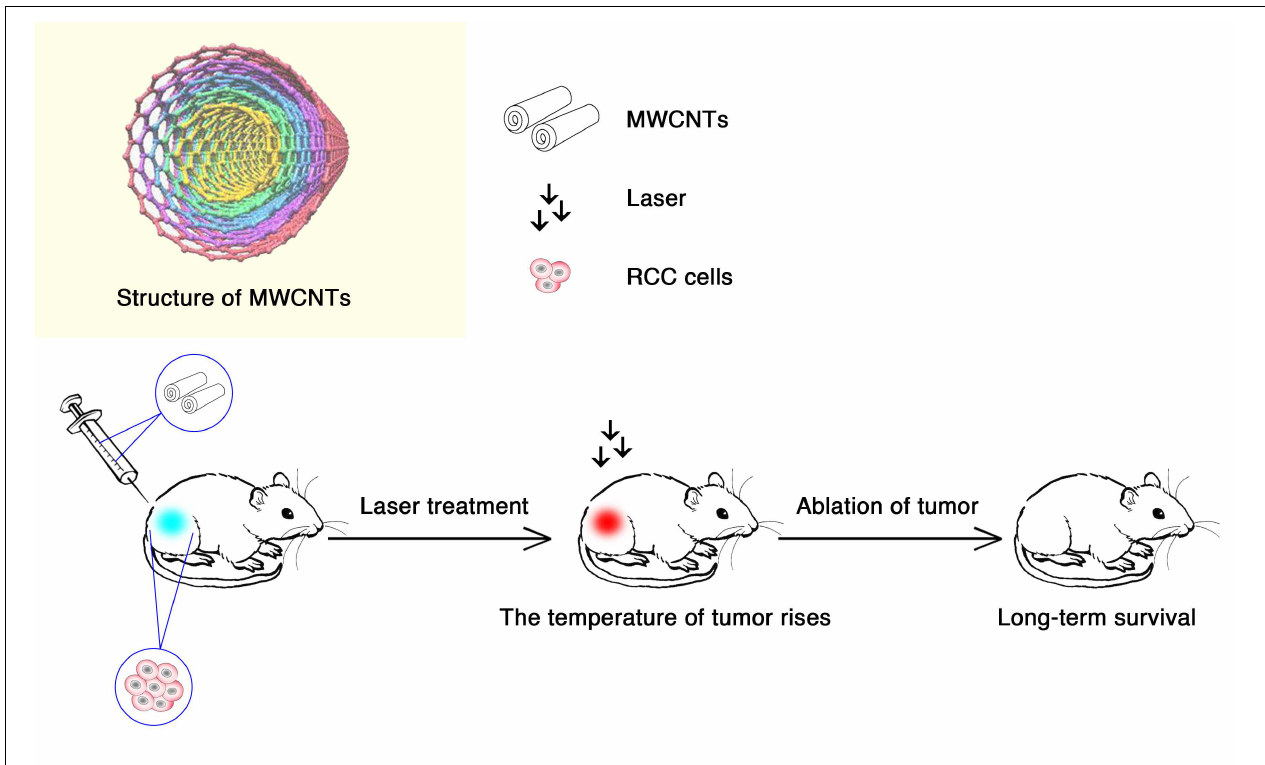
FIGURE 2 | Multiwalled carbon nanotubes (MWCNTs) ablate tumors. Tumor-bearing mice were injected intratumorally with 50 µ L of treatment solution containing 100, 50, or 10 µ g of MWCNTs (Burke et al., 2009). Tweety-four hours after the injection, they were irradiated with a 1,064-nm NIR laser for 30 s (3 W/cm 2 ; spot size, 5 mm). In the presence of the laser, MWCNTs increased intratumoral temperatures to a level sufficient to induce tumor ablation, resulting the long-term survival in tumor-bearing mice.